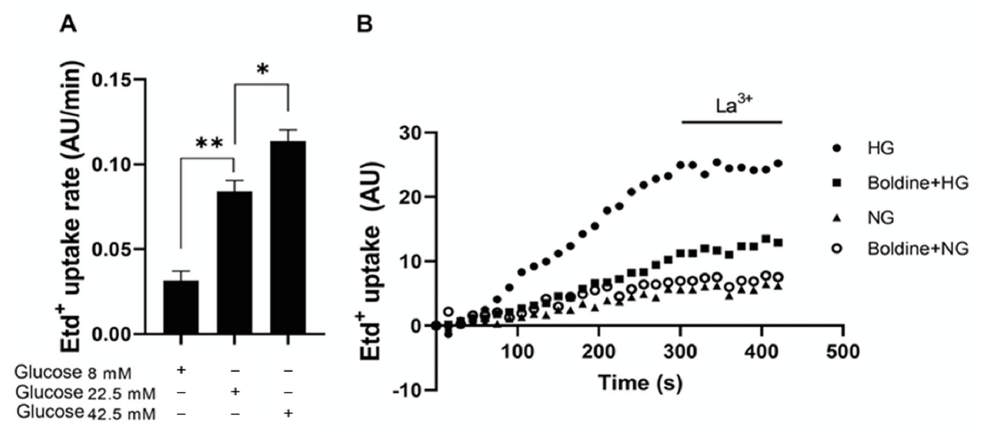
Figure 7. High glucose increases the sarcolemma permeability of cultured skeletal myofibers. ( A ) Etd + uptake rate of myofibers cultured for 24 h in DMEM/F12 culture medium plus different glucose concentrations. Each value is the mean ± SEM of nuclear Etd uptake rate. * p < 0.05 and ** p < 0.01 by ANOVA with Tukey ′ s multiple comparisons test. N = 3–6. ( B ) Representative fl uorescence intensity curve of Etd + uptake of myo fi bers cultured for 24 h with 8 mM glucose (NG), 8 mM glucose plus 50 µM boldine (Boldine + NG), 22.5 mM glucose (HG), or 22.5 mM glucose (HG) plus 50 µM boldine (Boldine + HG). At about 300 s recording, cells were treated with 200 µM La 3+ , a known HC blocker. High glucose enhances the presence of NLRP3, an in fl ammasome marker, which was inhibited by boldine. Given that myo fi bers express the molecular components of the in- fl ammasome that become activated under an acquired pathological condition such as de- nervation, and because inhibition of Cx HCs prevents its activation [5], we decided to test whether high glucose could a ff ect the in fl ammasome found in myo fi bers. To this end, we cultured myo fi bers as described above and tested NLRP3 immunoreactivity after 24 h of culture under control conditions treated with 22.5 mM glucose or 25.5 mM glucose plus 50 µM boldine. NLRP3 reactivity in control myo fi bers and in muscle fi bers cultured with 22.5 mM glucose + 50 µM boldine was similar between them but lower than myo fi bers cultured in 22.5 mM glucose alone (Supplementary Figure S2). The la tt er suggests that